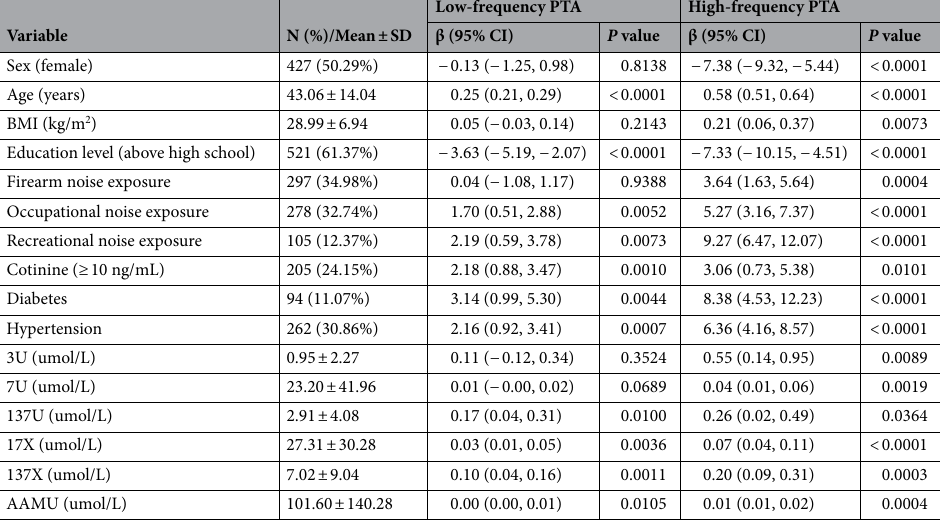
Table 2. The univariate analysis of comparison of variables in low-frequency and high-frequency PTA